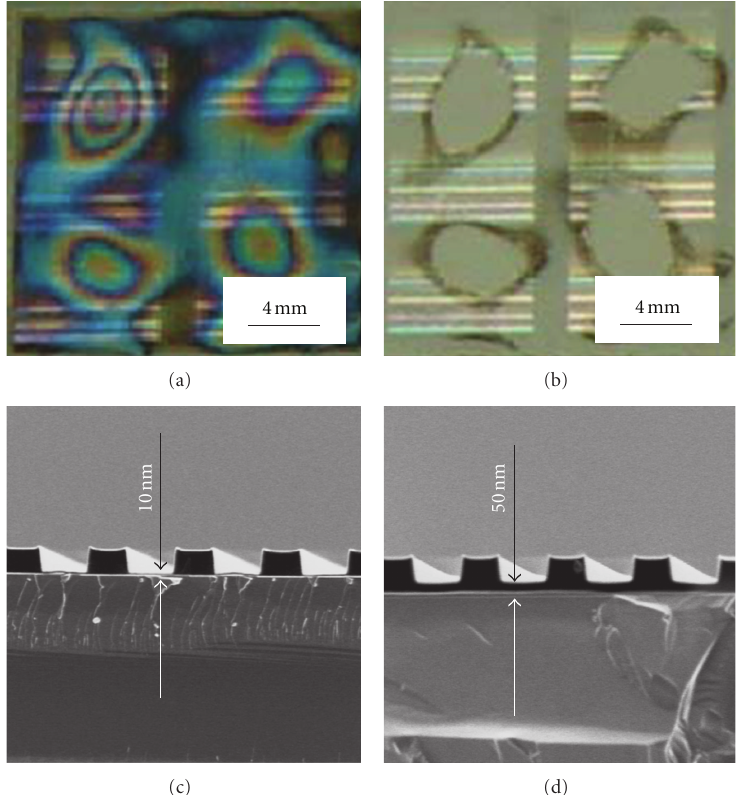
Figure 1: Nonuniform residual layer thickness, (a) nonuniform residual layer thickness appears as fringes, (b) pattern was not formed after reactive ion etching, (c) cross-sectional image, residual layer thickness was 10 nm, and (d) cross-sectional image, residual layer thickness was 50nm.